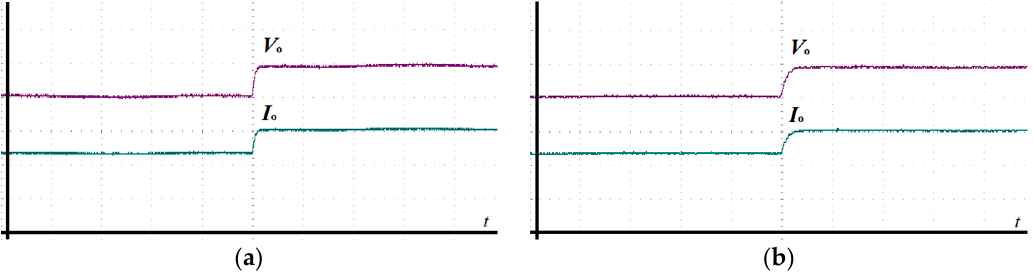
Figure 13. Dynamic response when the output reference current changes suddenly, V o (10 V/div), I o (1 A/div). ( a ) traditional PCC; ( b ) SMPCC.